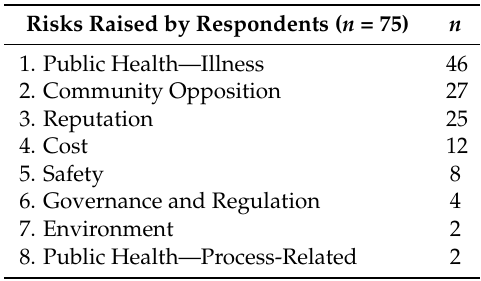
Table 3. Expert risk perceptions associated with the removal of fluoride from the potable supply, and frequency of